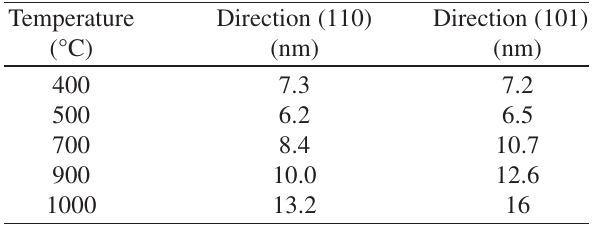
+0.1%Er xerogel as function 2 :0.1%Er xerogel. 2